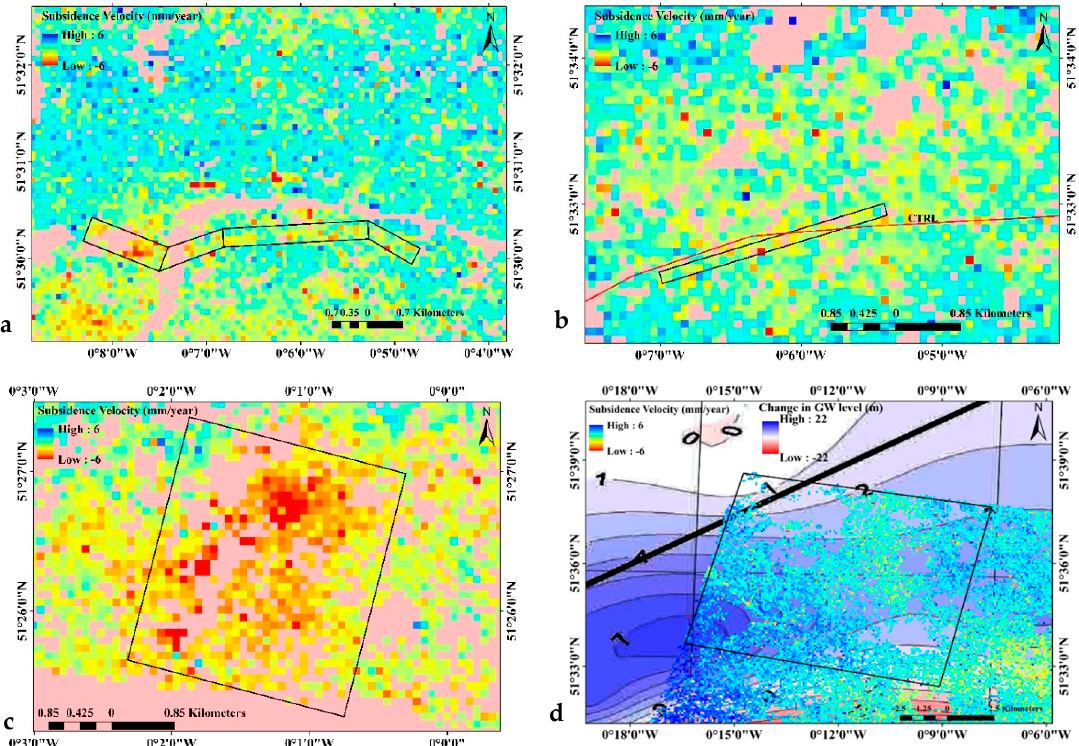
Figure 8. PSInSAR site specific subsidence maps for London. ( a ) Area crossing Thames river; ( b ) area on the north of Thames river and passing through CTRL (Channel Tunnel Rail Link); ( c ) area on the south of Thames river showing distinct subsidence; ( d ) area on the north of Thames river overlaid on groundwater contour provided by EA.